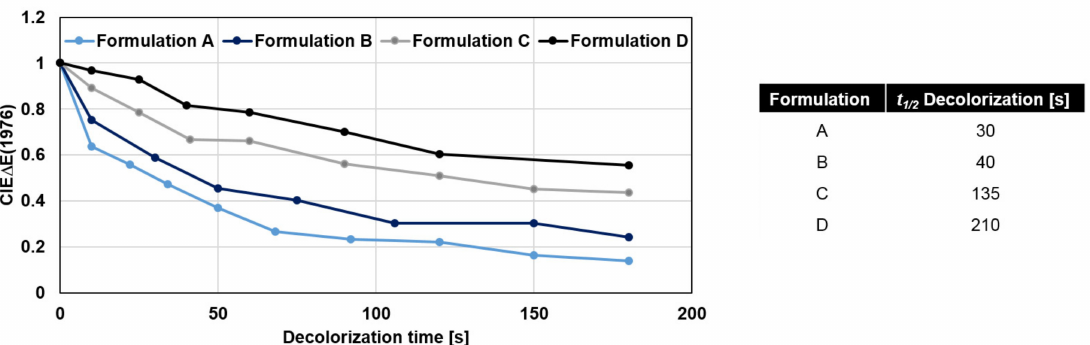
Figure 9. Decolorization dynamics and half-life periods t 1/2 of decolorization of yellow VIS-trigger-able photochromic 12 µ m prints of formulations A, B, C and D by varying the reactant ratio of the colorant system. Relative CIE ∆ E(1976) values are relative color differences with regards to the maximum color difference within a single series which is the color difference directly after the illumination period at t = 0